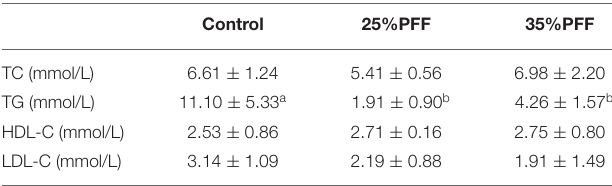
TABLE 2 | Effect of probiotic fermented feed on serum lipid parameters in ducks.